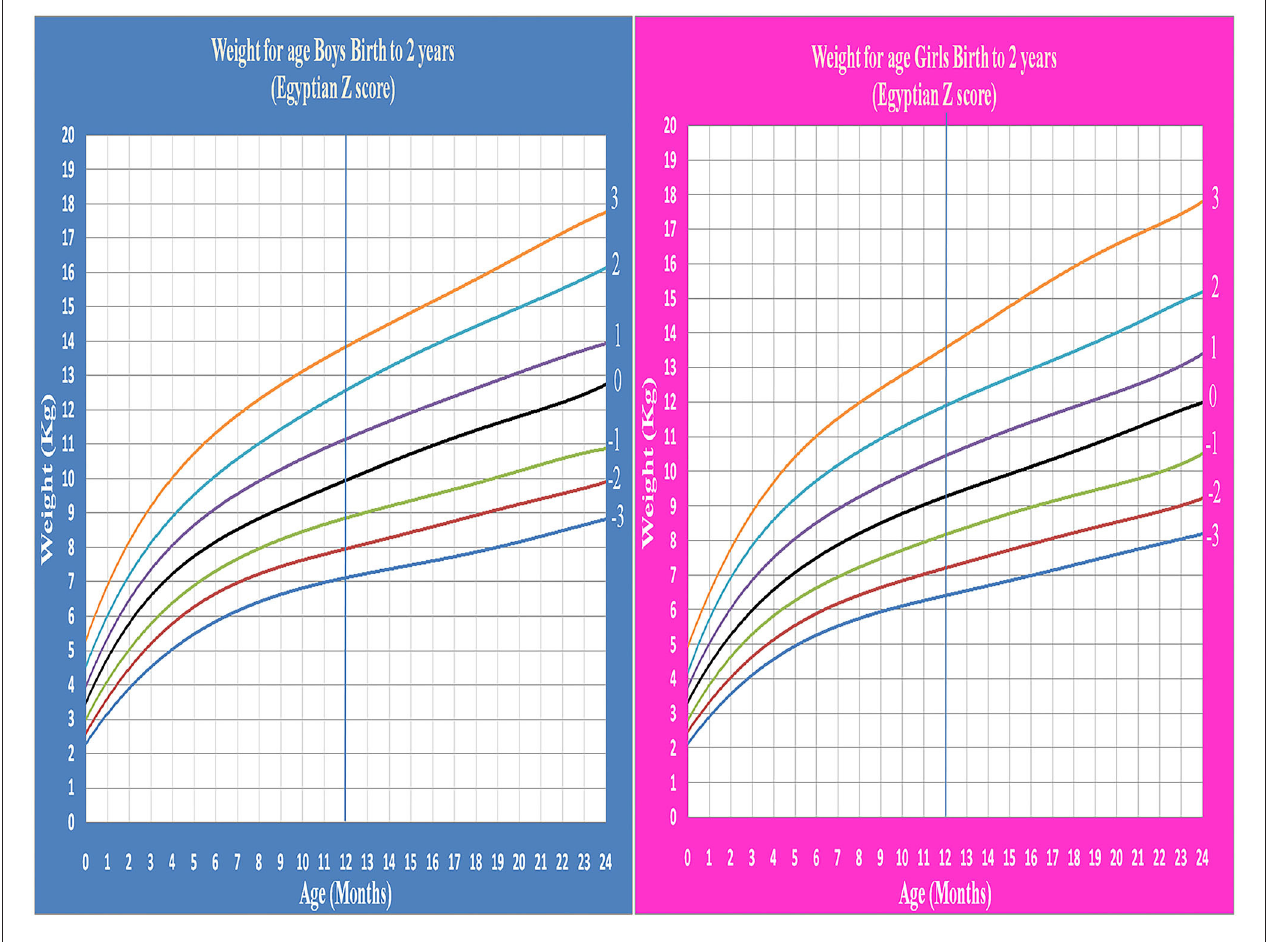
FIGURE 1 | Egyptian Z score weight for age from birth to 2 years for boys &